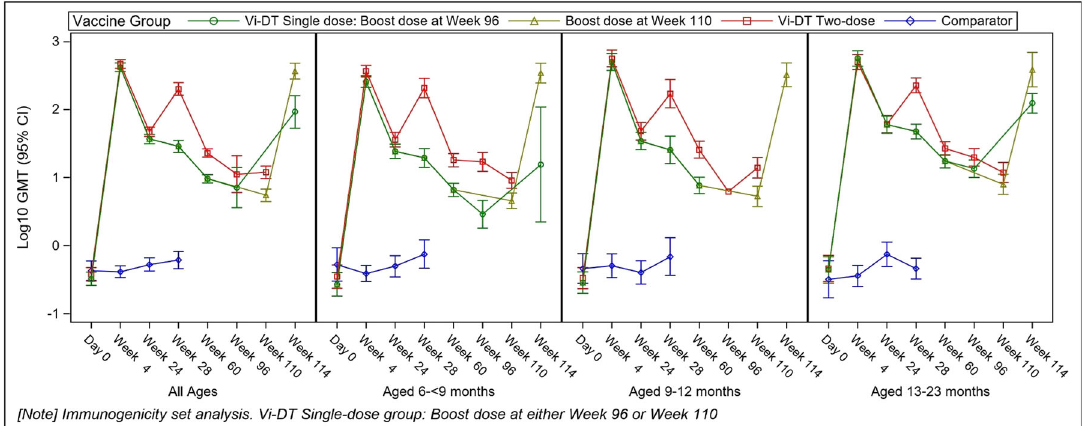
Fig. 2 Log-transformed titer of anti-Vi IgG ELISA response using the immunogenicity analysis set. The x axis represents the immunogenicity blood-draw timepoints including for all age groups and by age group, while the y axis presents the log 10 -transformed geometric mean titers (GMTs). The dotted vertical lines represent the vaccination